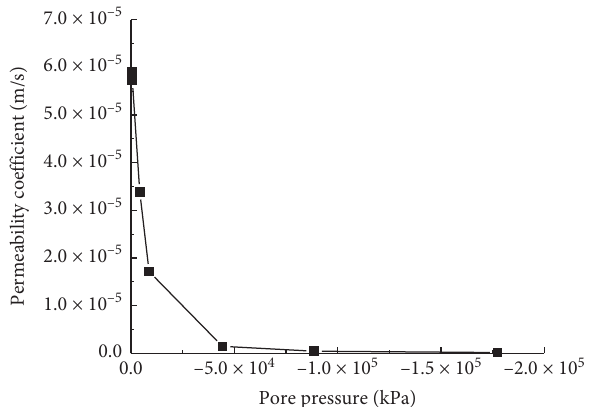
Figure 1: Relationship between the permeability coefficient and pore pressure of soil.